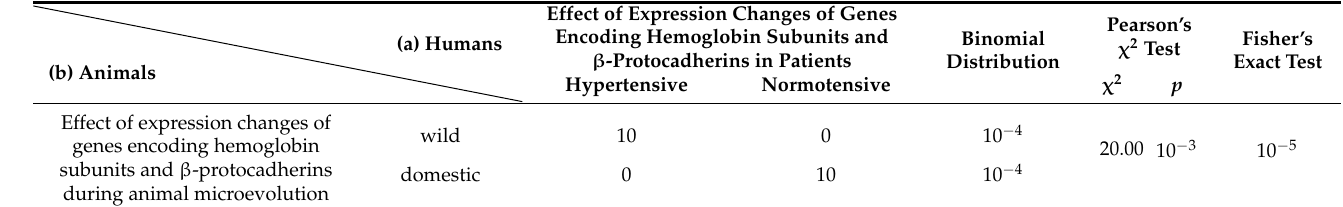
Table 10. Correlations between the effects of unidirectional changes in the expression of homologous genes (a) on human hypertension and (b) during the divergence of studied domestic and wild animals from their most recent common